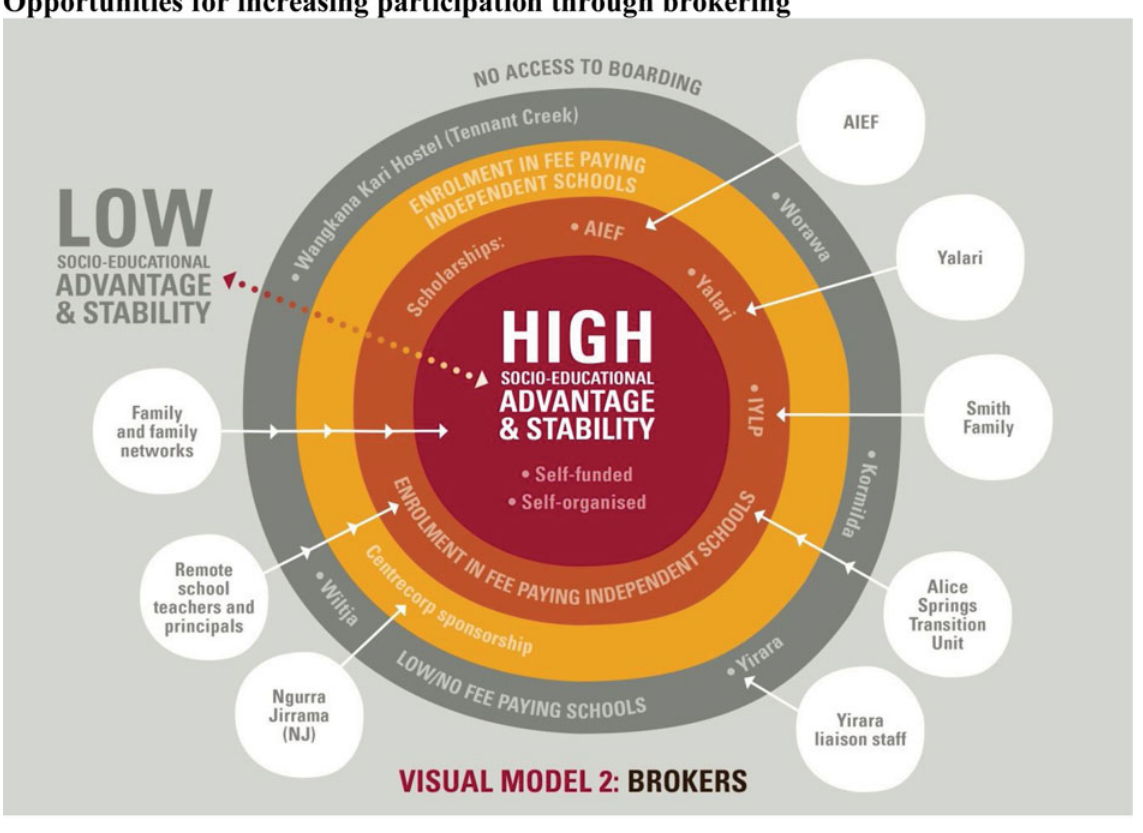
(Colour online) Visual model 2 showing the relationship between boarding schools and brokers, families and remote